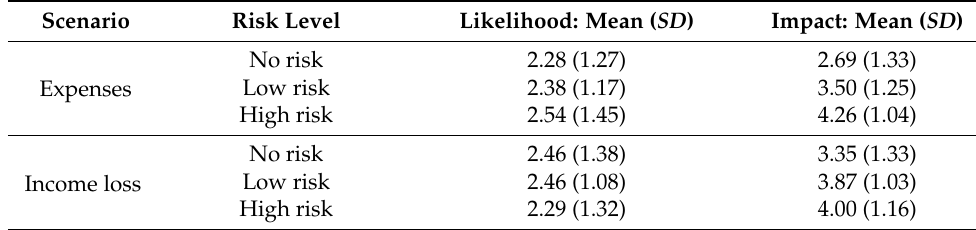
Table 2. Perception